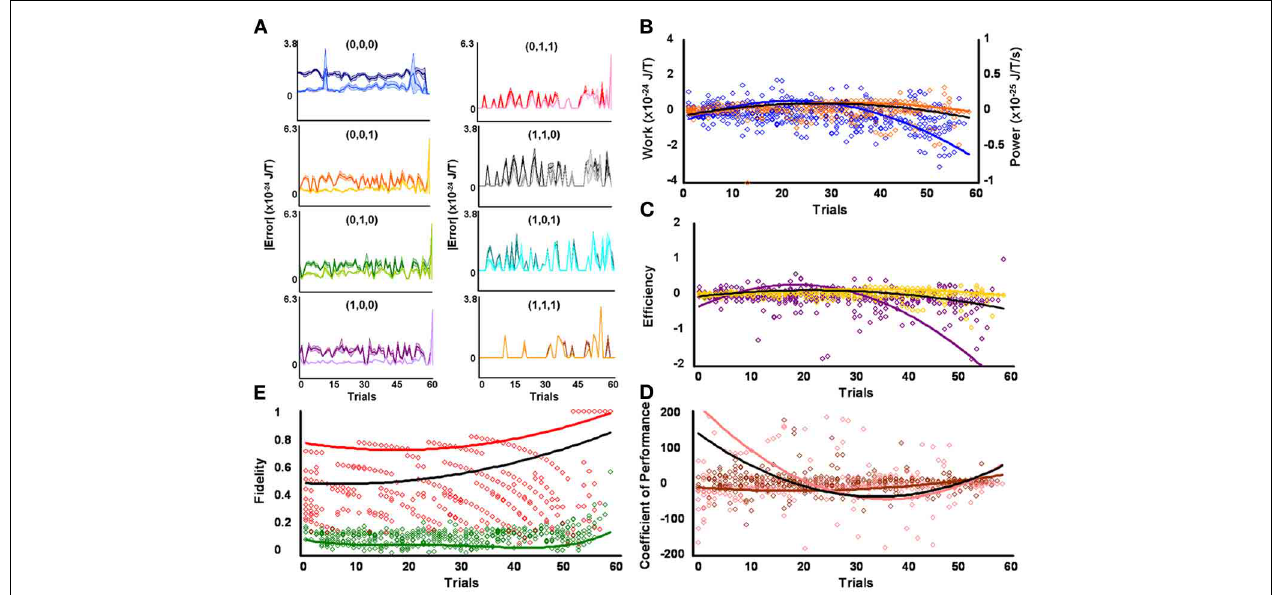
FIGURE 2 | Initial low responders learn to diagnose and correct classical errors in executed contraction strategies signaling mating fitness. (A) Repetition coding prevented errors in executed serial contraction signals from exceeding estimated single bit-flip errors in absolute mean average Boltzmann entropy [executed (light blue) and bit-flipped (dark blue) strategy (0,0,0), executed (light orange) and bit-flipped (dark orange) strategy (0,0,1), executed (lime green) and bit-flipped (green) strategy (0,1,0), executed (lavender) and bit-flipped (purple) strategy (1,0,0), executed (pink) and bit-flipped (red) strategy (0,1,1), executed (gray) and bit-flipped (black) strategy (1,1,0), executed (turquoise) and bit-flipped (teal) strategy (1,0,1), executed (gold) and bit-flipped (brown) strategy (1,1,1)]. (B) Differences in mean average Boltzmann entropy between strategy planning and execution stages were expelled by ciliates when learning to detect and correct errors in modal (orange) and non-modal (blue) serial contraction signals. Negative trends in work and associated power functions show that serial strategies